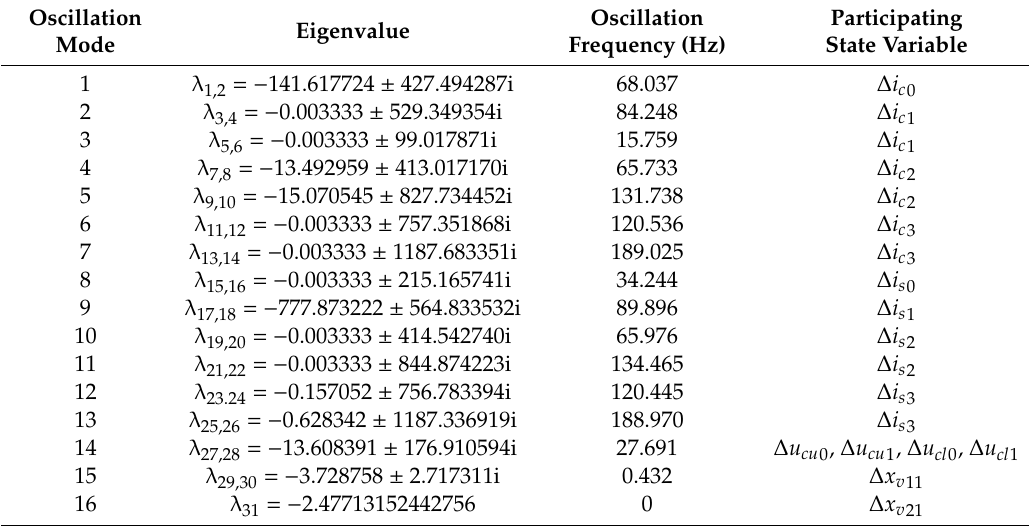
Table 2. The oscillation modes of the MMC systems and their main participating state variables. Oscillation